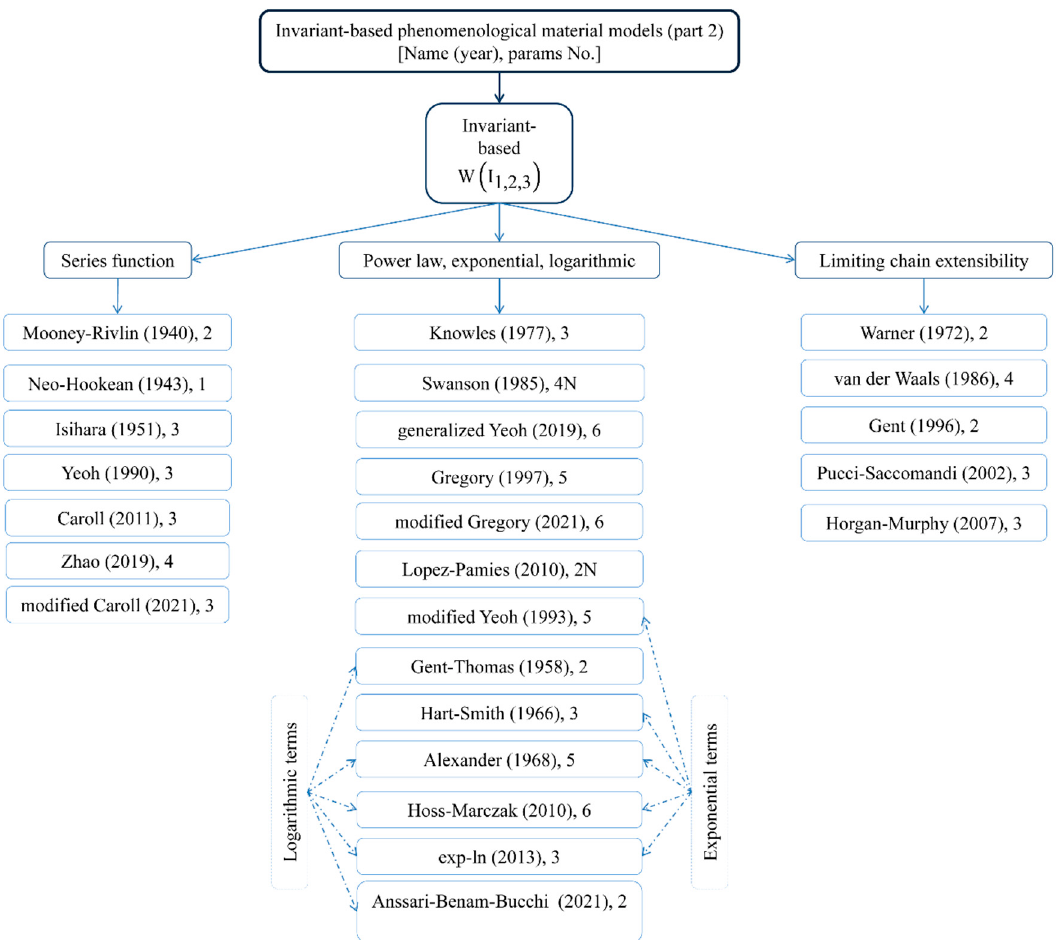
Figure 2. Different phenomenological models of hyper-elastic materials (part 2).